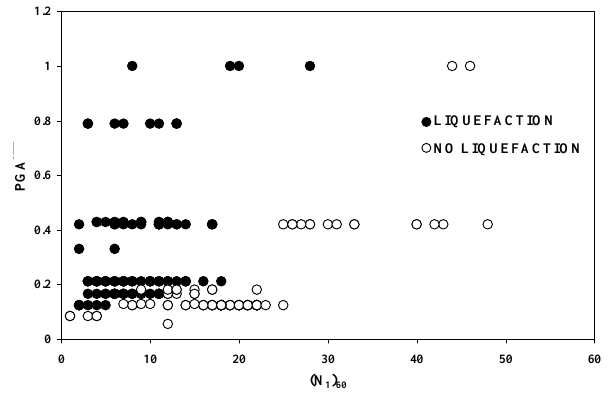
Figure 14. Plot between PGA and (N 1 ) 60 for MODEL II using radial basis function for Fig. 14. Plot between PGA and (N 1 ) 60 for MODEL II using radial testing dataset. basis function for testing dataset.